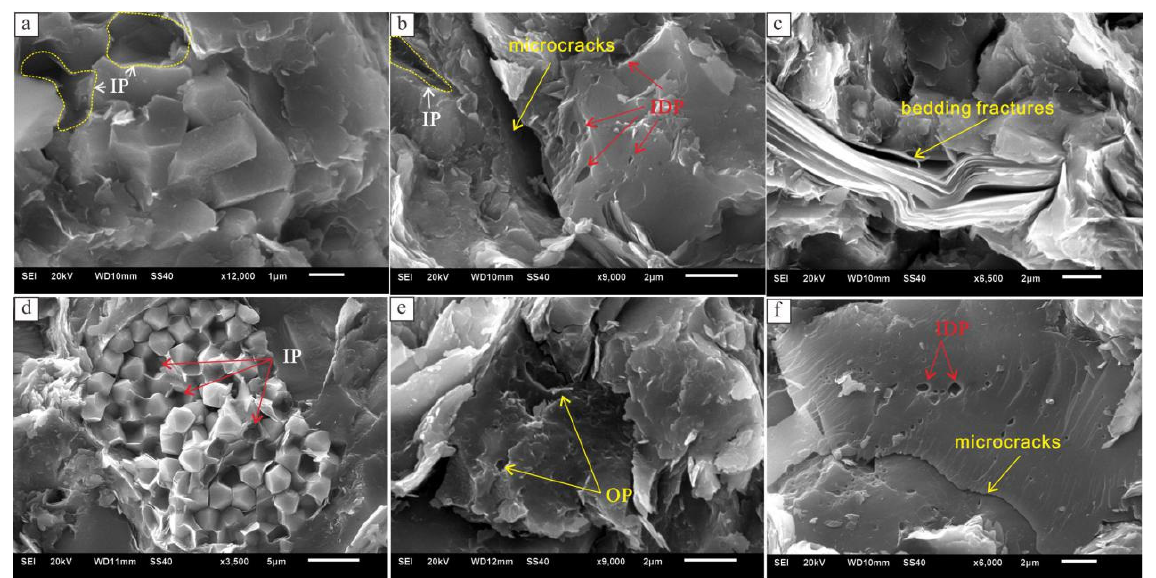
Figure 7. Microscopic characteristics of pores in shale reservoir of Well Yucan-6 (SEM). ( a ): Intergranular pores (IP) are distributed in pyrite within YC06-1 (Well Yucan-6) at 697.30 m; ( b ): Intragranular dissolved pores (IDP) existing in quartz grains, and intergranular pores and microcracks in YC06-6 (Well Yucan-6) at 708.71 m; ( c ): Bedding fractures of clay minerals in YC06-6 (Well Yucan-6) at 708.71 m; ( d ): Intergranular pore (IP) in Pyrite in YC06-19 (Well Yucan-6) at 722.53 m; ( e ): Organic pore (OP) in YC06-19 (Well Yucan-6) at 714.60 m; ( f ): Microcracks and intragranular dissolved pores (IDP) in YC06-41 (Well Yucan-6) at 744.50 m.